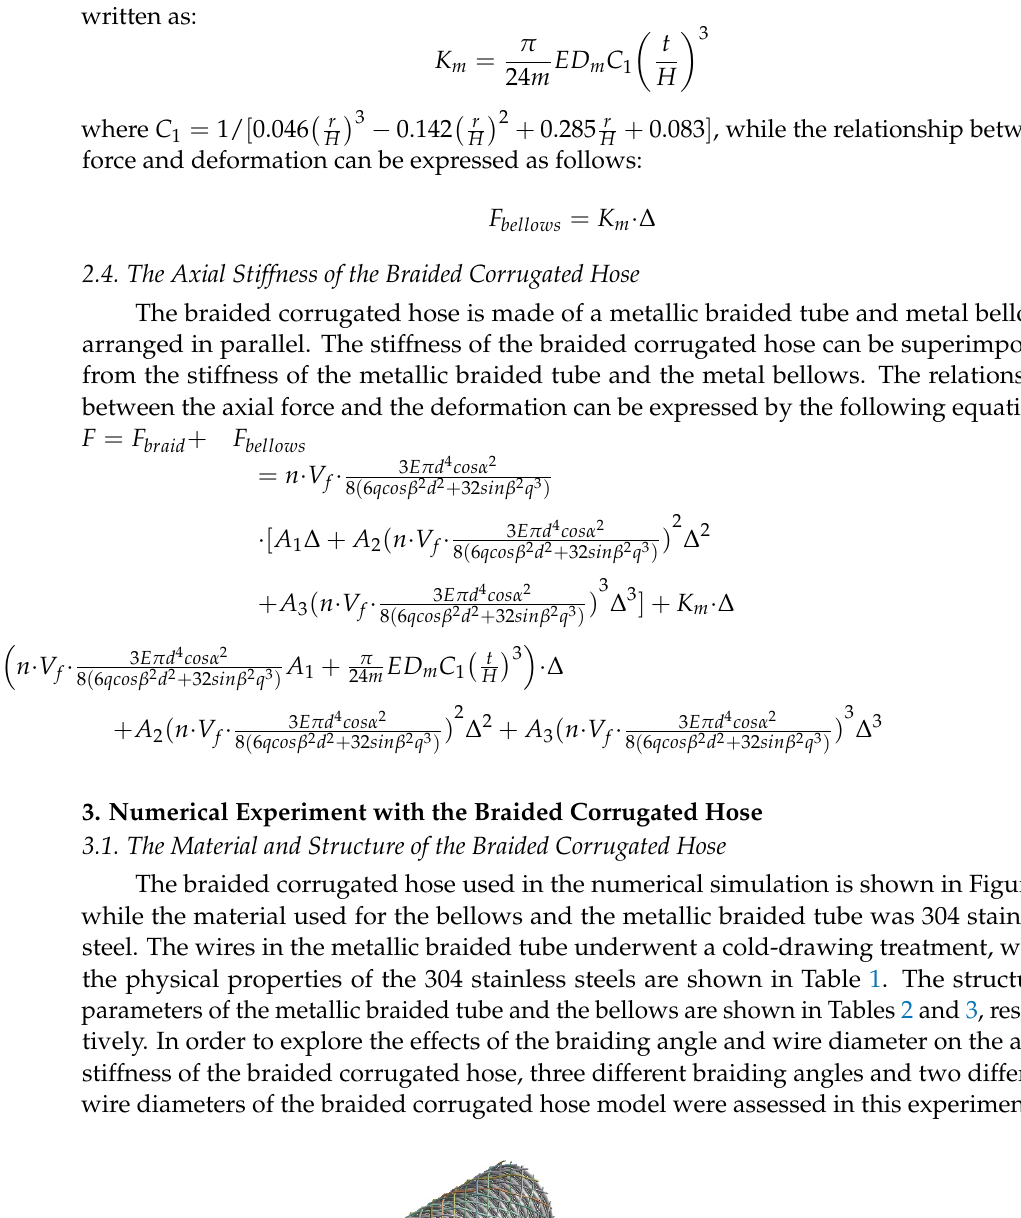
Table 2. Structural parameters of the metallic braided tube.